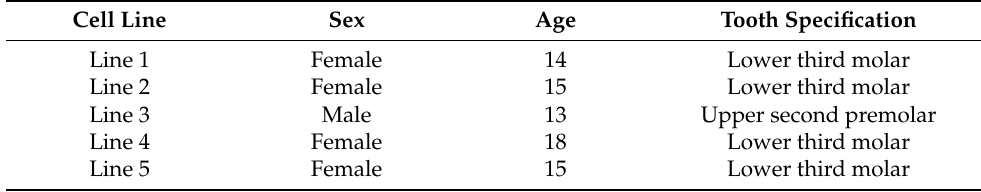
Table 1. Sex and age of the tooth donors and tooth